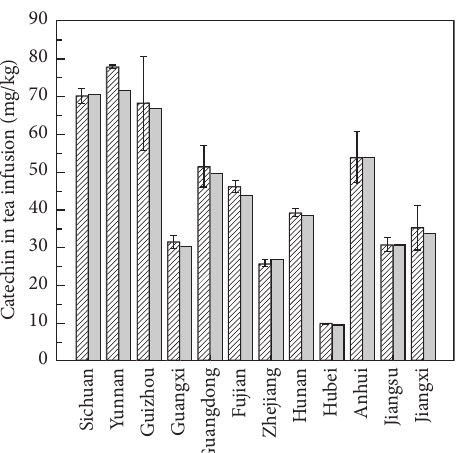
Figure 8: Catechin content of 12 tea samples as determined by high-performance liquid chromatography (shadow) or by fluorescence spectroscopy (gray). The results indicated that the catechin density deduced from fluorescence measurement are strongly linked to the value obtained by high-performance liquid chromatography. Table 2: Catechin contents in tea infusion from different regions by fluorescence method and HPLC.